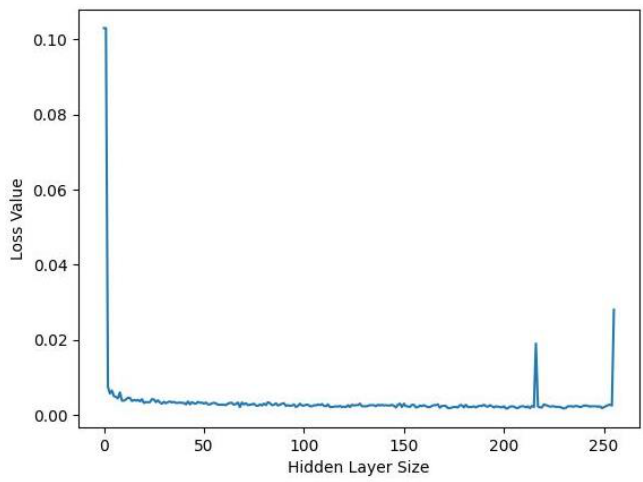
Figure 7. Loss changes with the hidden layer size changes.